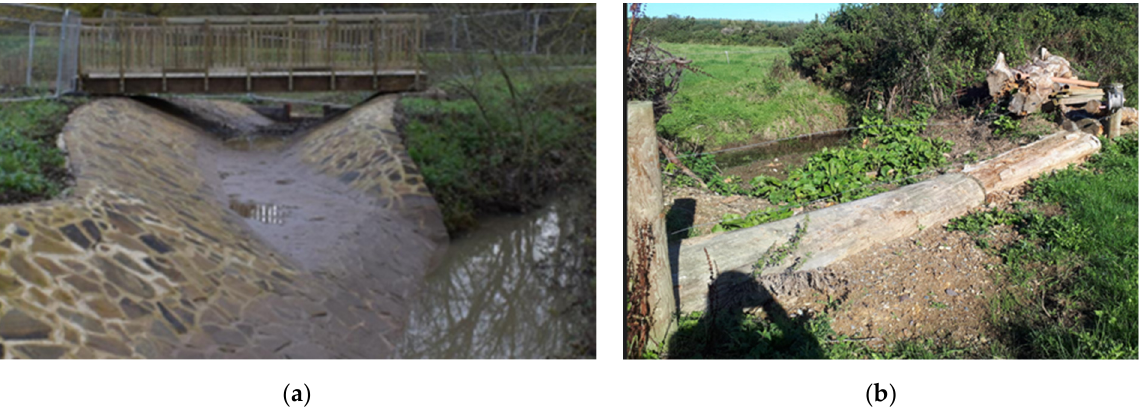
Figure 5. Draw off structures at Coatham Woods lowering the bank, Co. Durham ( a ) and SloWaters Project Co. Wexford, Ireland ( b ) raising the overflow level [48].